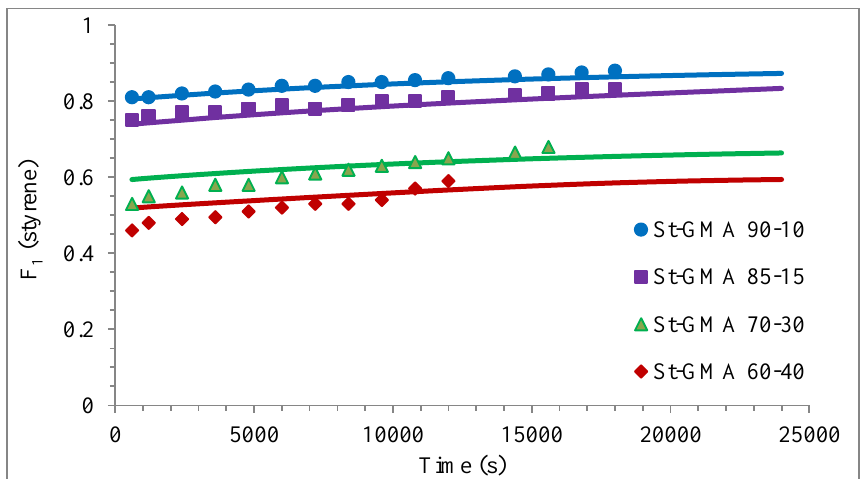
Figure 5. Profiles of overall conversion versus time for the different St-GMA samples. Symbols represent experimental data, whereas solid lines correspond to model predictions.